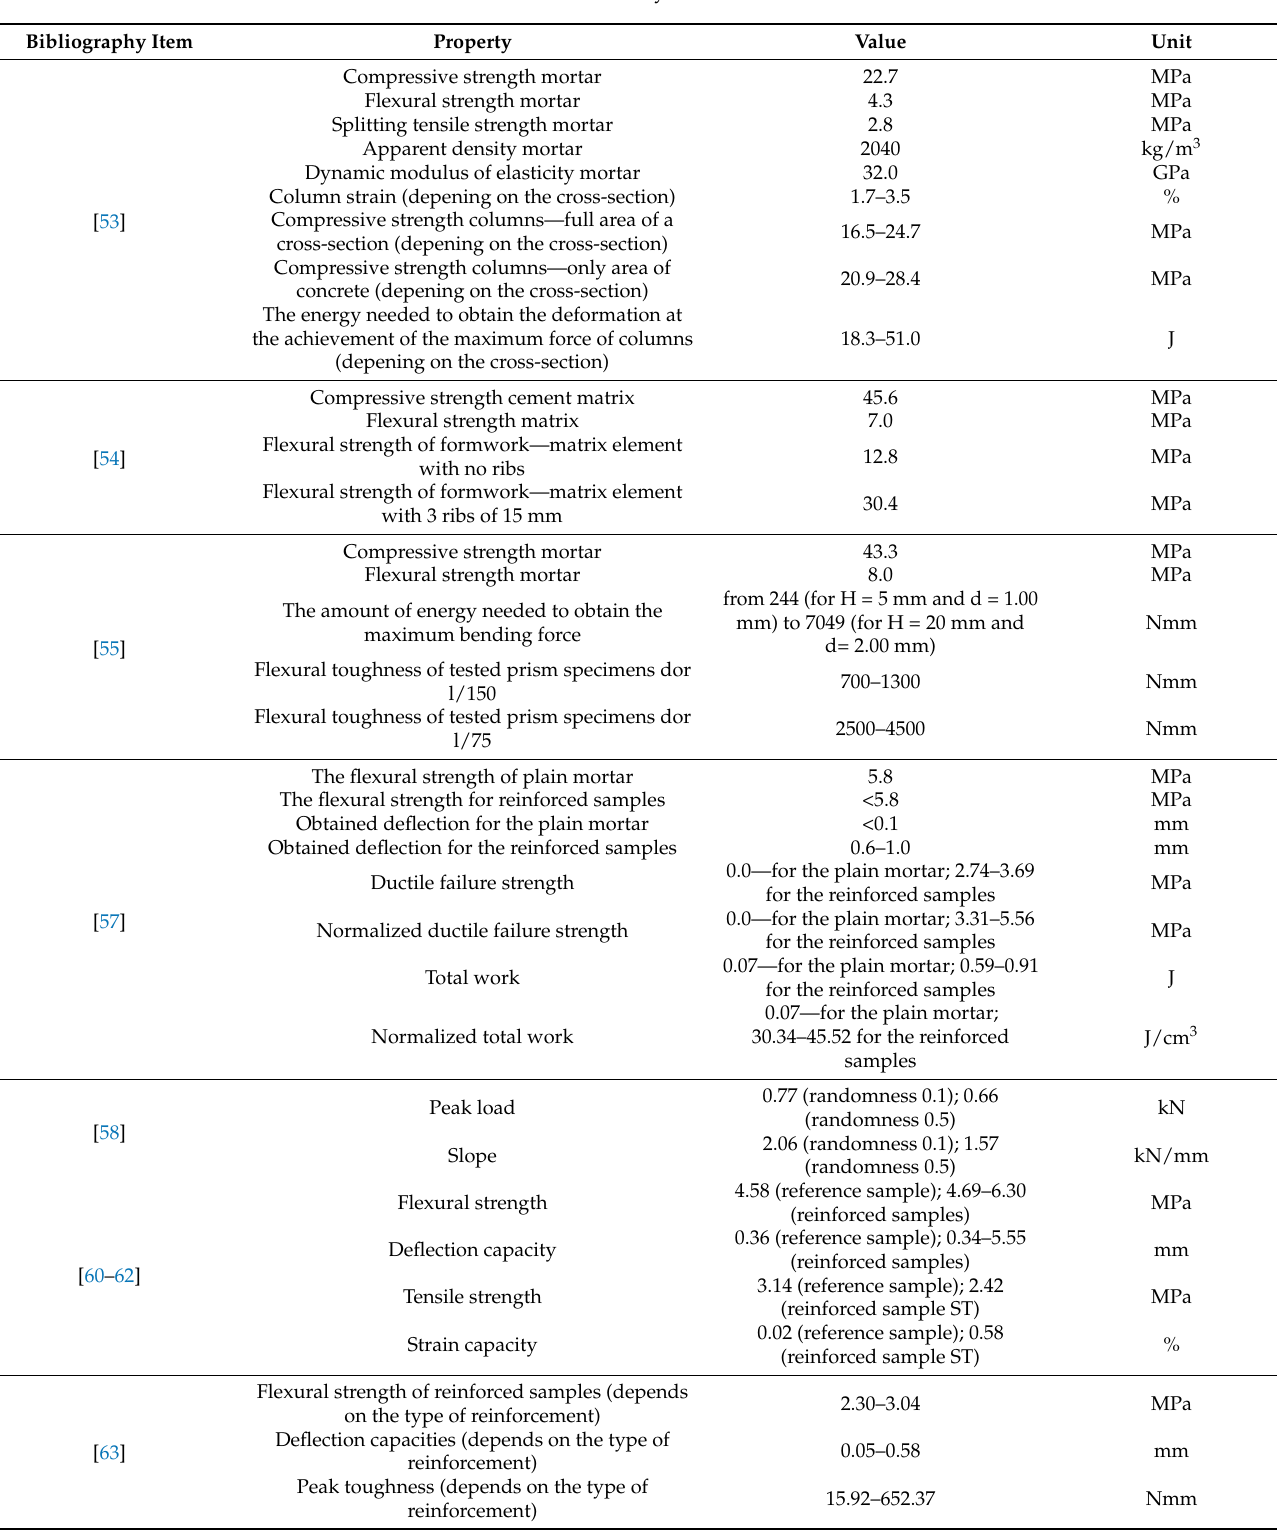
Table A1. Summary of the